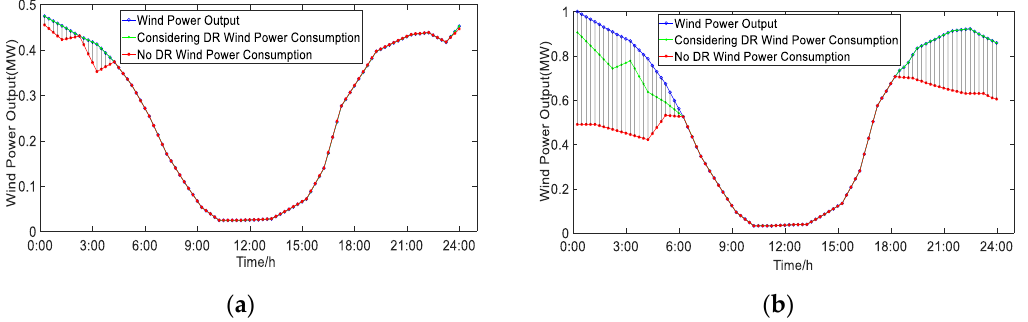
max max P P = 0.5 MW. ( b ) = 1 MW. , e w , e w